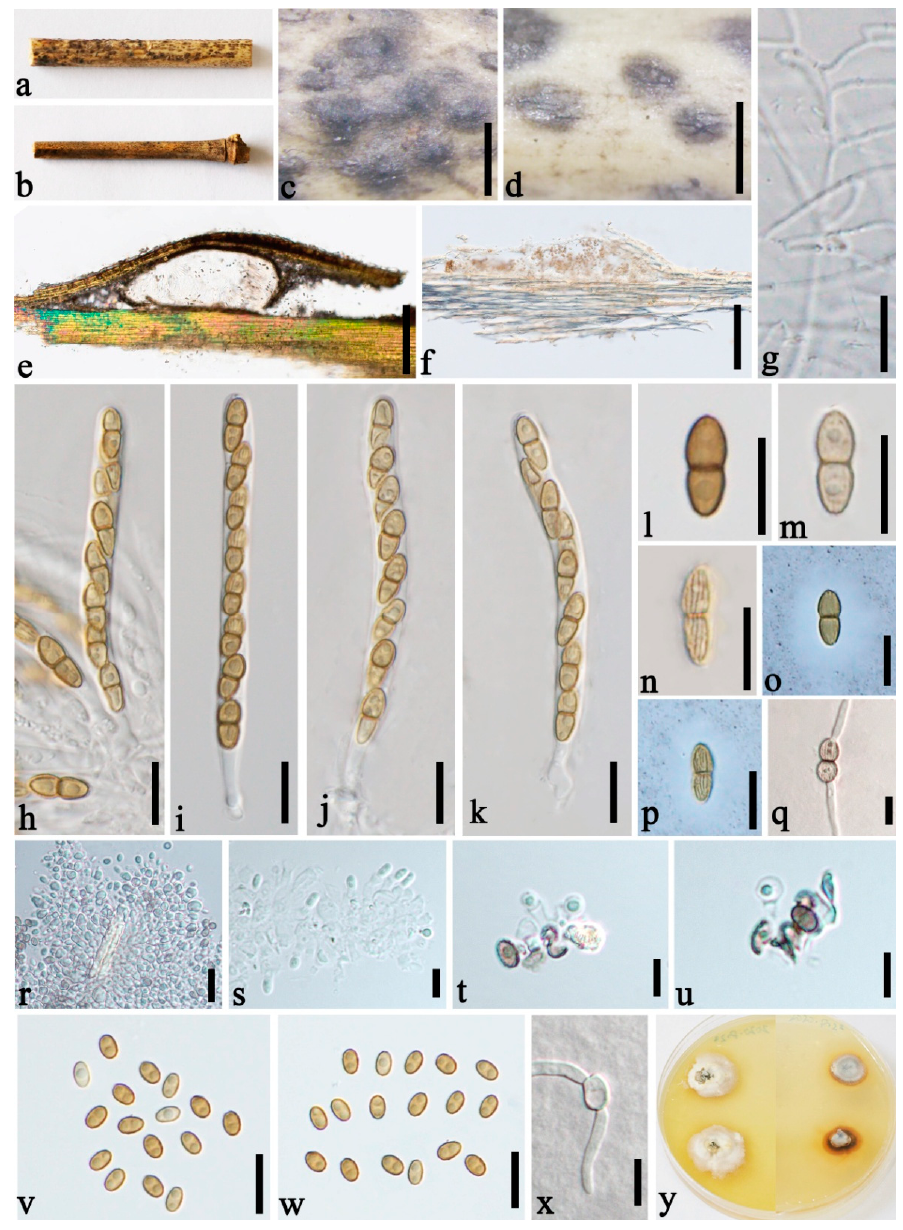
Figure 4. Roussoella kunmingensis (GMB1203, sexual morph, ( a , c , e , g , h – q ); GMB1259, first report of asexual morph, ( b , d , f , r – y )). ( a , b ) Bamboo specimens; ( c ) black ascostromata on host surface; ( d ) black conidiomata on host surface; ( e ) vertical section of ascostromata; ( f ) vertical section of conidioma; ( g ) pseudoparaphyses; ( h – k ) asci; ( l – n ) ascospores; ( o , p ) ascospores in India ink; ( q ) germinating ascospore; ( r – u ) conidiogenous cells contacting with conidia; ( v , w ) conidia; ( x ) germinating conidium; ( y ) cultures on PDA from above and below. Scale bars: ( c ) = 500 µ m, ( d ) = 300 µ m, ( e ) = 200 µ m, ( f ) = 100 µ m, ( g – x ) = 10 µ